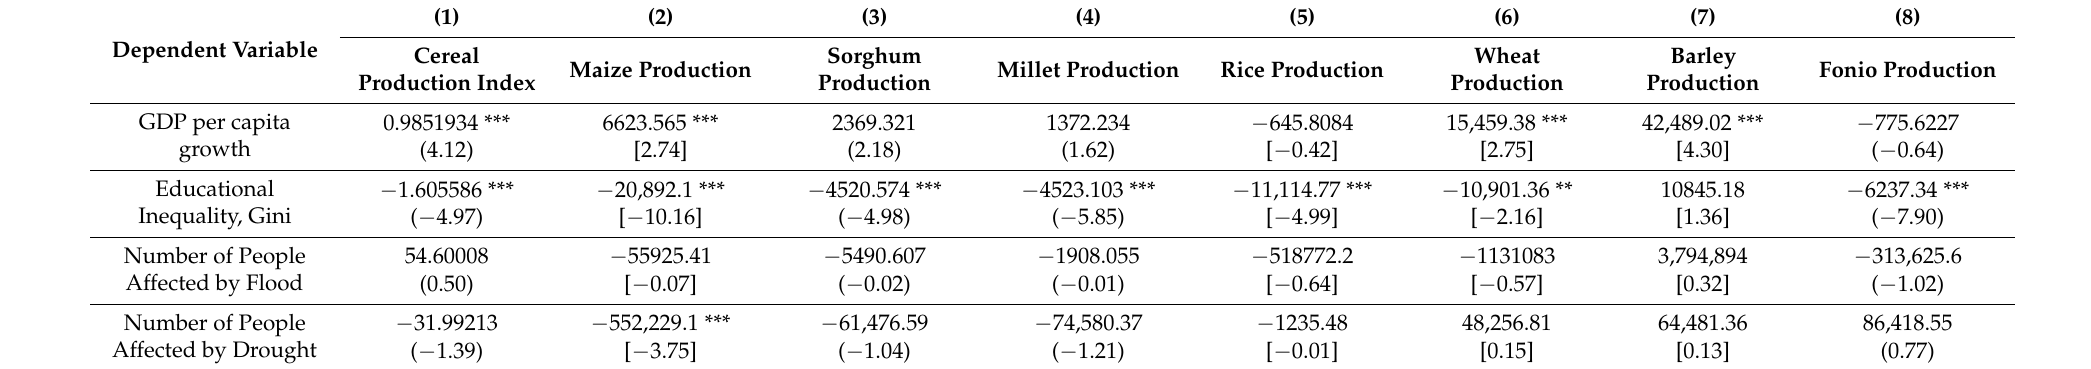
Table 6. Cereal Food Aid and Cereal